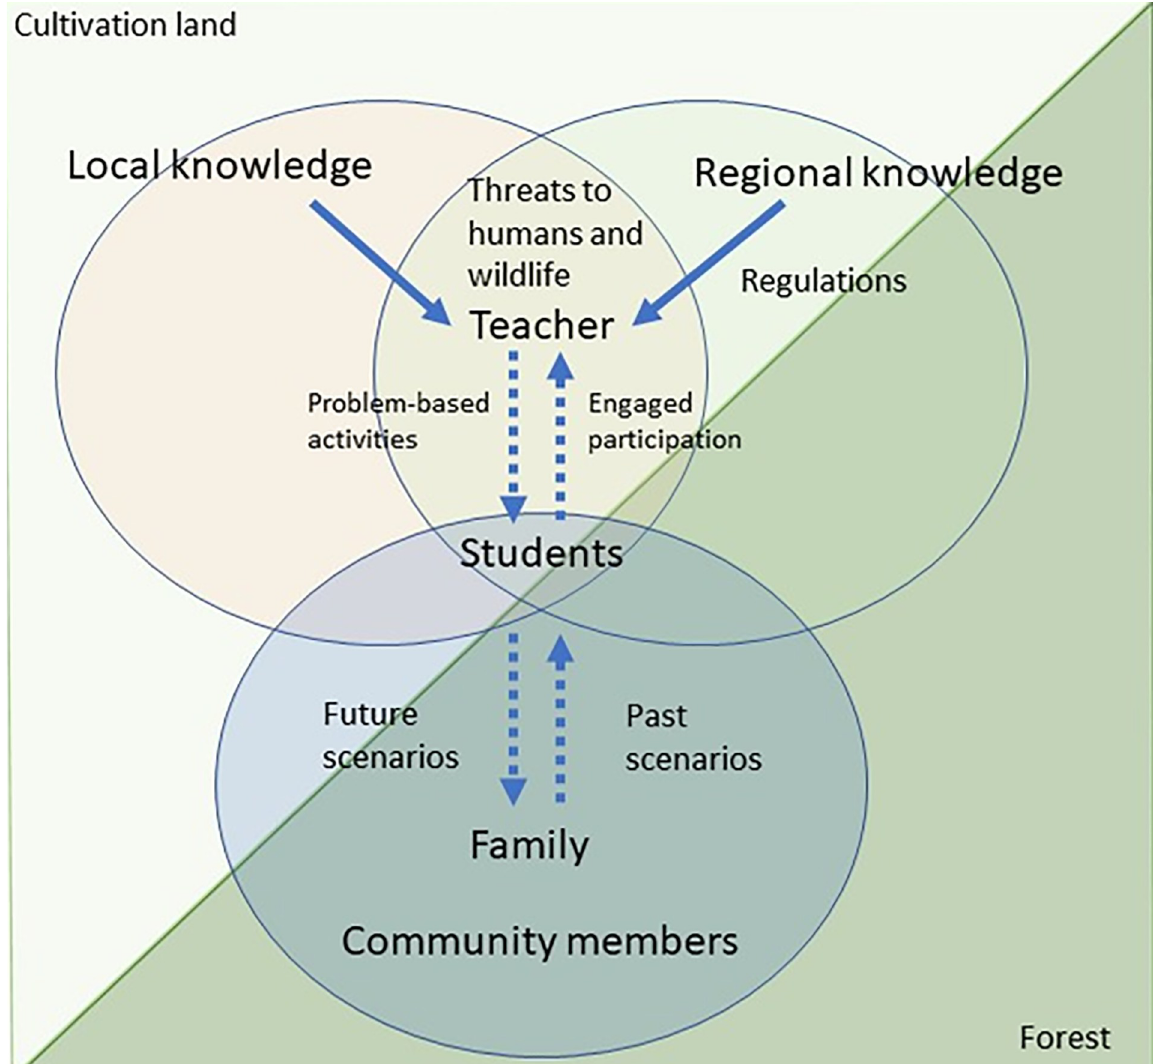
Fig 1. Proposed conglomerate of information, directional flow, participants and scenarios involved in environmental education